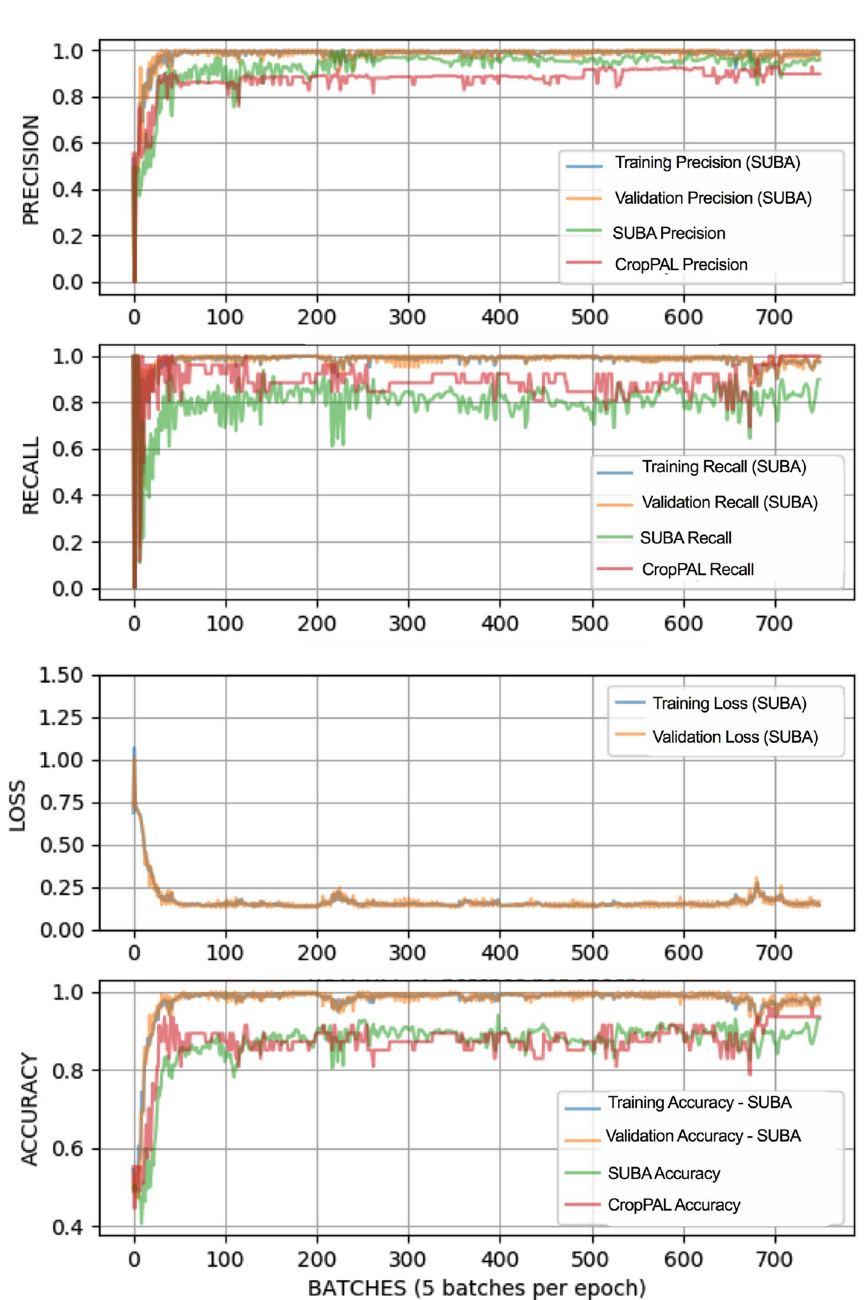
Figure 3. Precision, recall, loss and accuracy progression during the training for the Bi-LSTM to classify entity relationships between proteins, experimental methodology and subcellular locations from input sentences. Training, validation and testing of the model was undertaken using the SUBA dataset and independently tested using the CropPAL